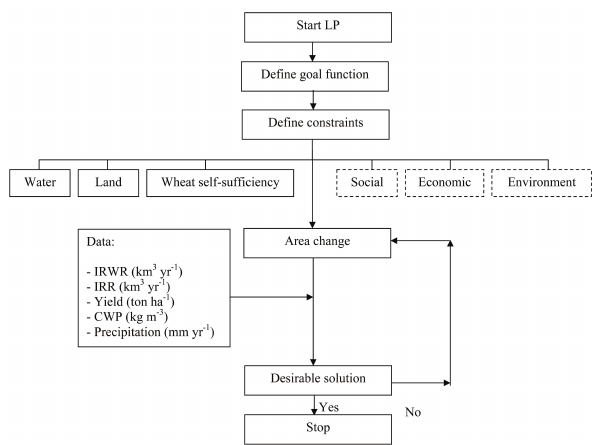
Fig. 1. Multi criteria decision analysis framework of the ASCP cor- responding to the VWT strategy. IRWR: internal renewable blue water resources, IRR: irrigation water requirement, CWP: crop wa- ter productivity. Dash lines in the constraint are the factors that were not considered in this study.